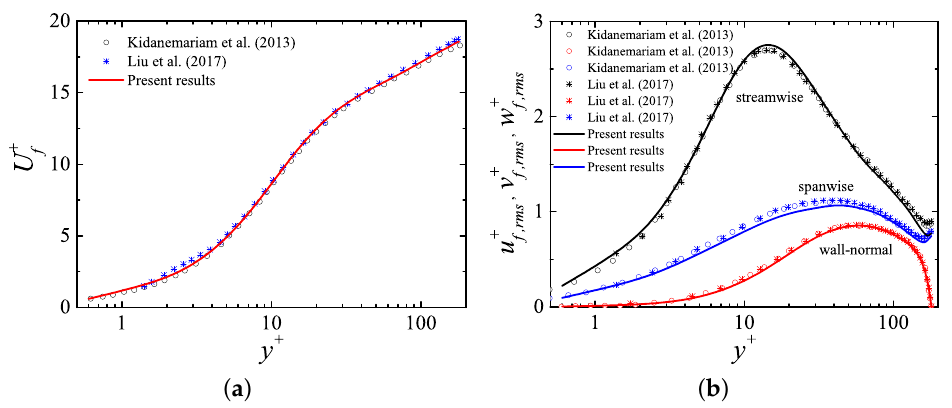
Figure 2. Comparison of results between the single-phase flow and the reference data: ( a ) Fluid mean streamwise velocity and ( b ) fluid root-mean-square (RMS) velocity fluctuation